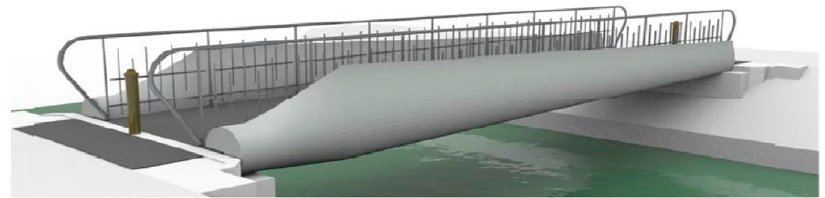
Figure A1. A conceptual design of a pedestrian bridge using part of A26 wind blades [44].